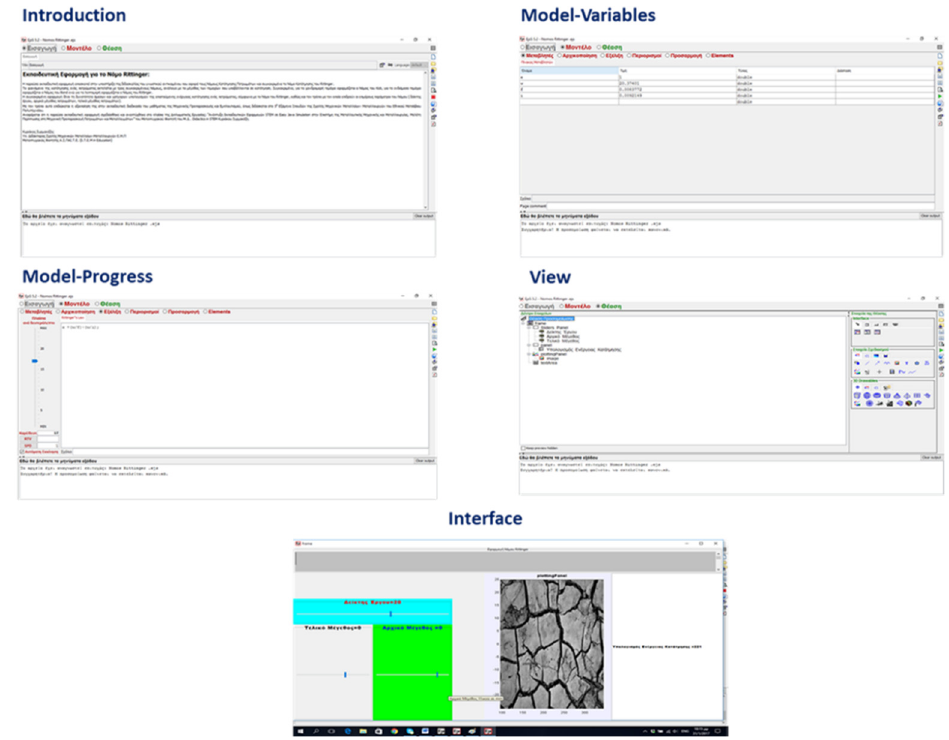
Figure 1. EJS work panels of developed STEM Educational Application .